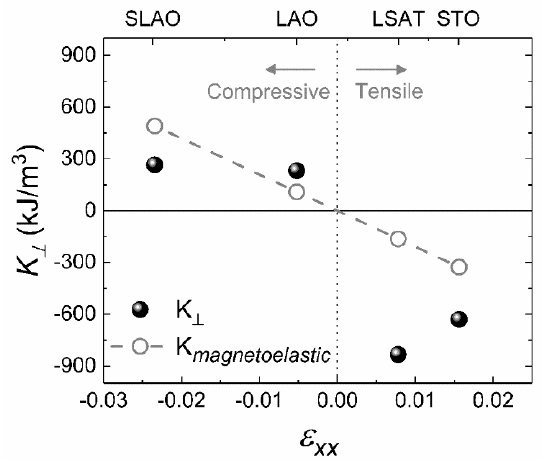
Figure 9. Closed circles correspond to the perpendicular magnetic shape anisotropy ( K ⊥ ) for LSCO films grown on tensile and compressive substrates, whose thickness is around 28 nm. Open circles and dashed line represent the magnetoelastic anisotropy contribution to K Ʇ (see text).